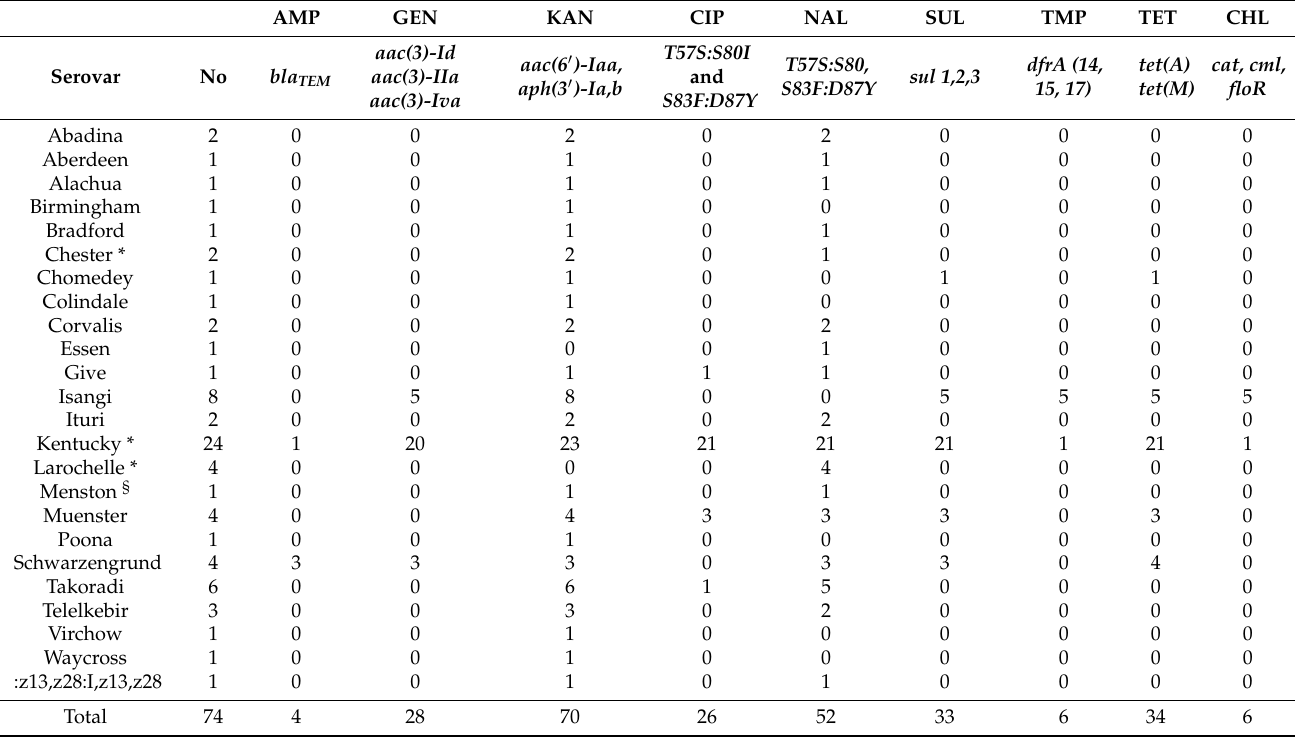
Table 2. Distribution of resistance genes in Salmonella serovars based on in silico